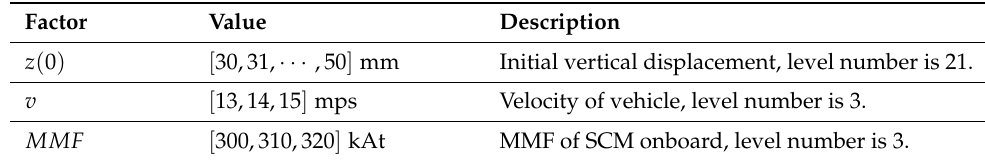
Table 3. Simulation factors and